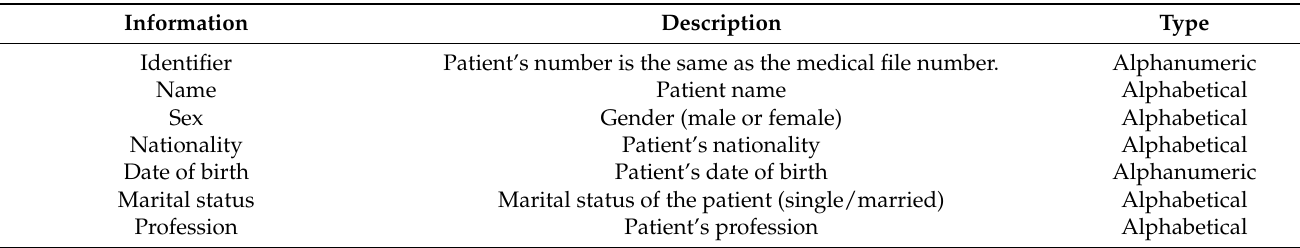
Table 1. Examples of patient-file